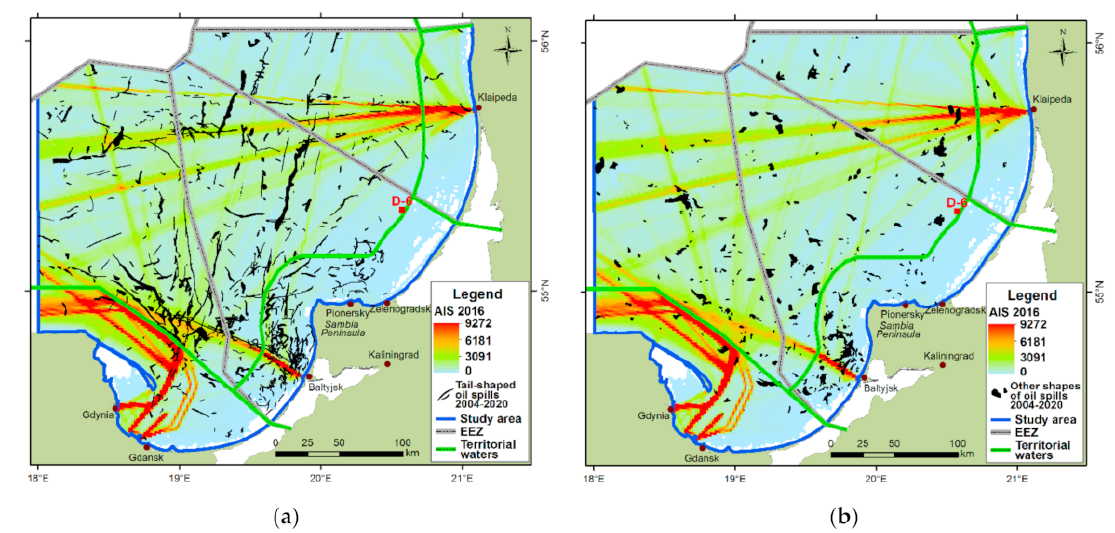
Figure 9. Spatial distribution of spills detected during 2004–2020 in the study area: ( a ) tail-shaped oil spills and ( b ) oil spills of other